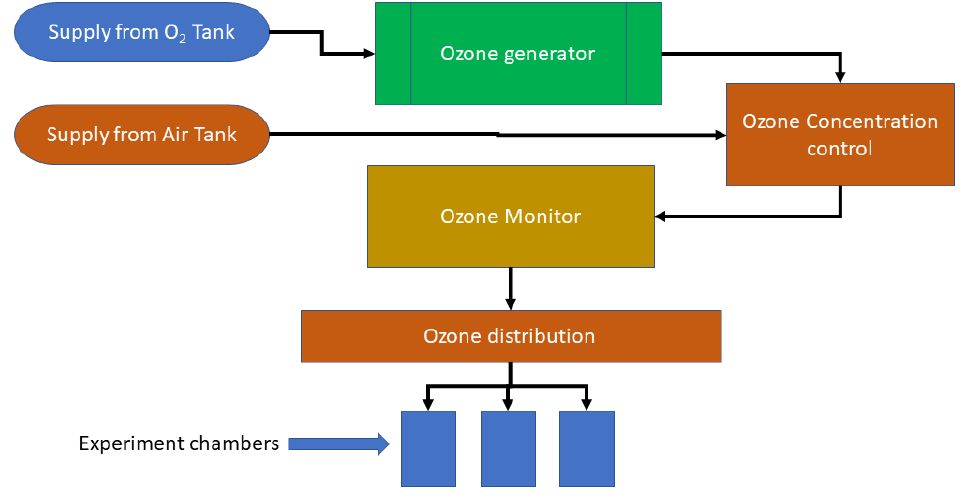
Figure 1. Schematics of bench-scale ozone treatment system.